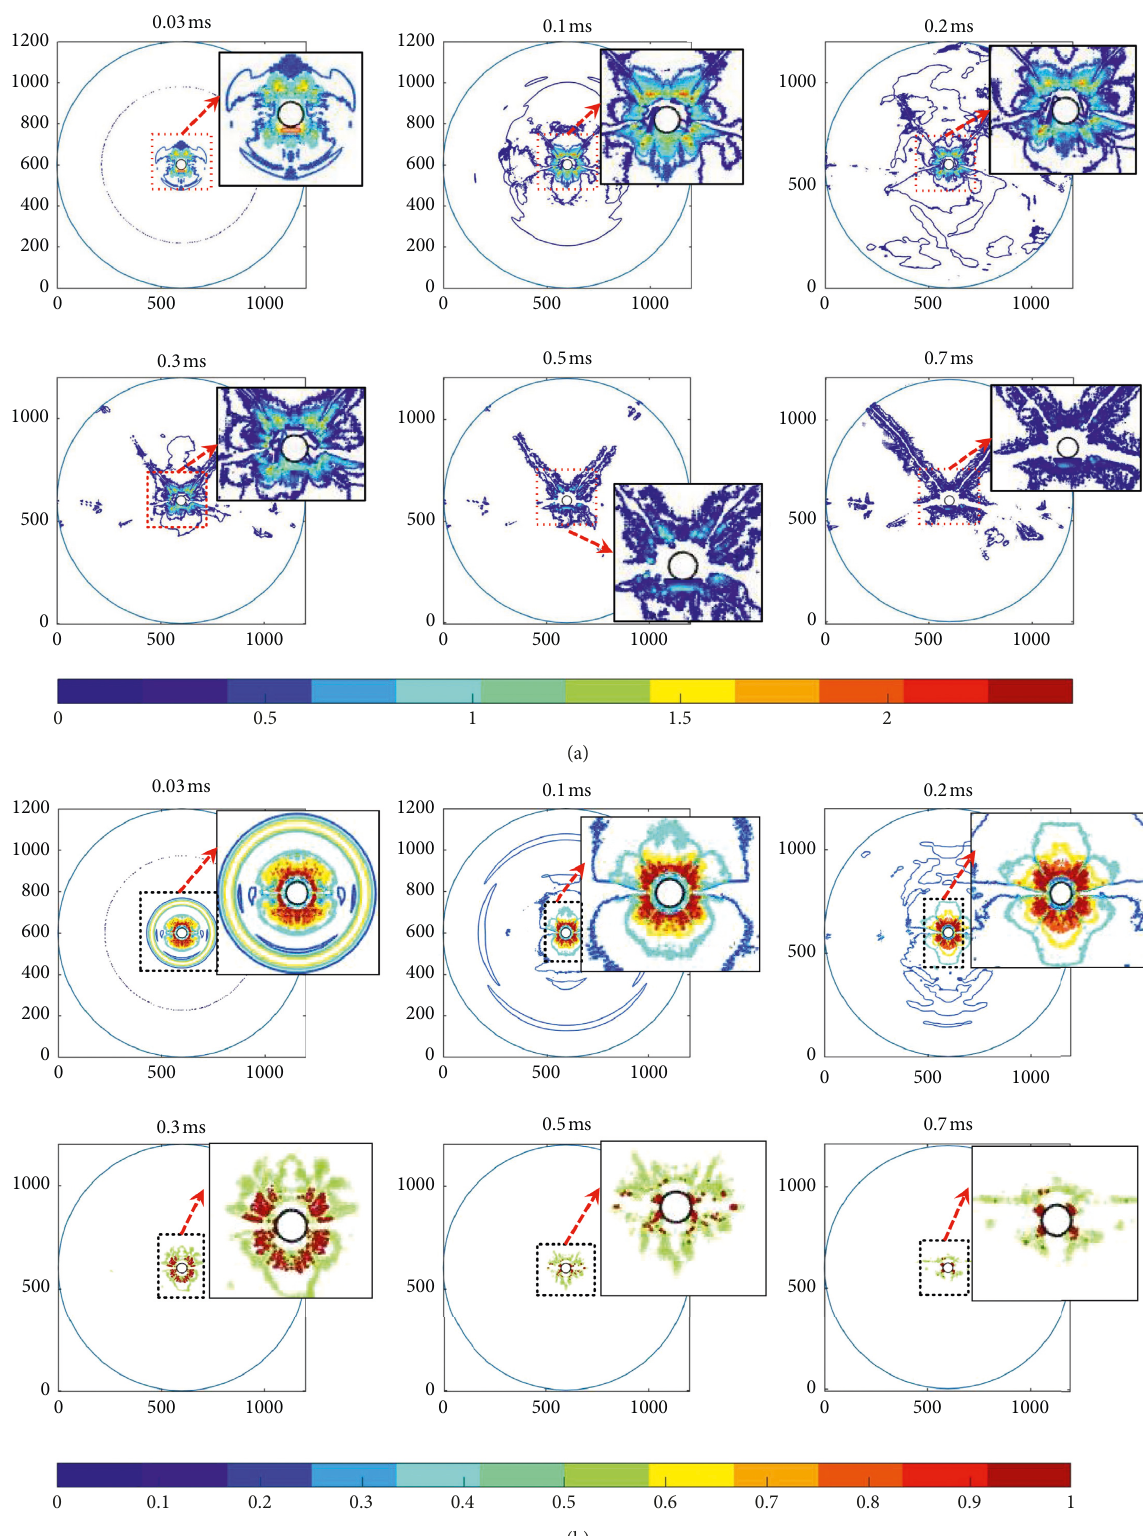
Figure 8: Equivalent stress evolution process after the blasting (unit: GPa). (a) Conventional method. (b) Automatic adaptive optimization